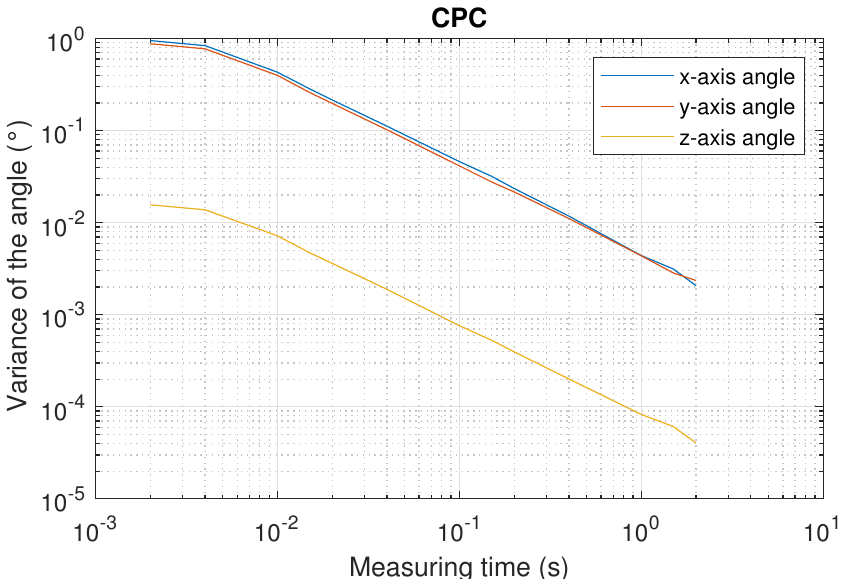
Figure 21. Mean value of the variance of the three axis orientation angles as a function of the measurement time using